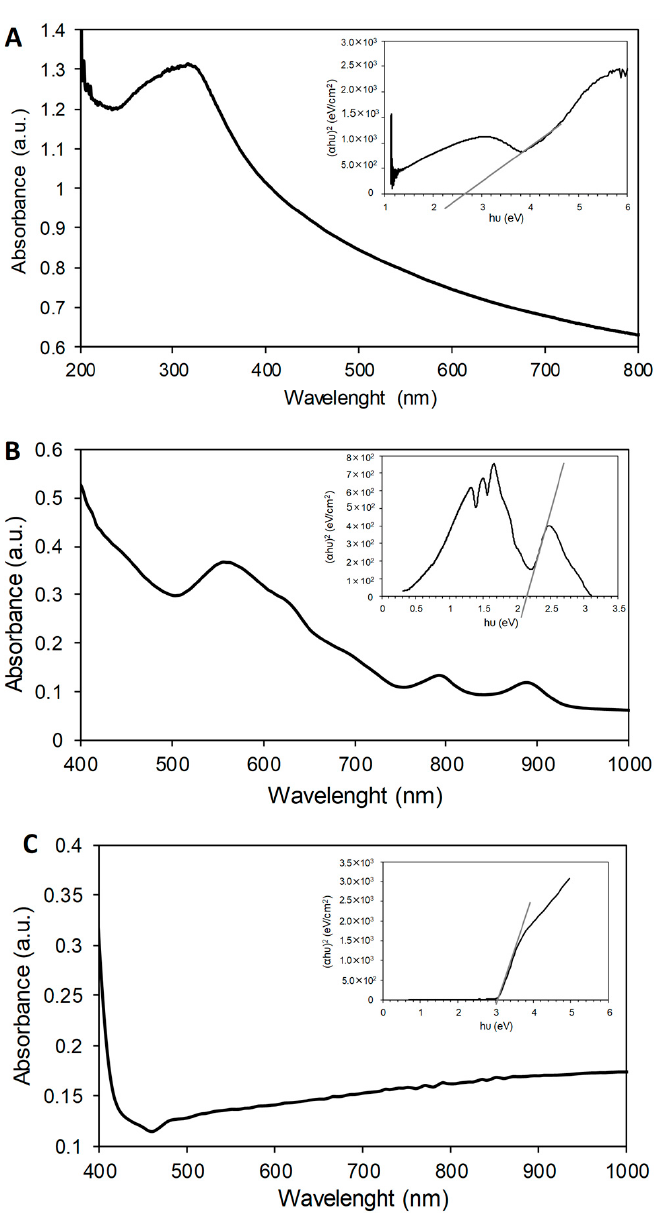
Figure 5. UV-Vis spectra and embedded Tauc’s plots of ( A ) Fe 3 O 4 –SiO 2 –TiO 2 catalyst ( B ) Fe 3 O 4 and ( C ) TiO 2